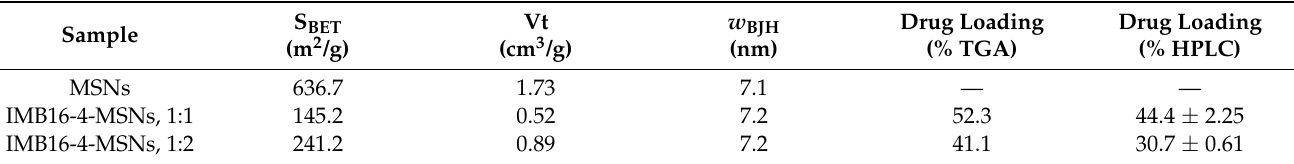
Figure 3. TGA of MSNs and IMB16-4-MSNs samples ( A ). UV-Vis absorption spectra of raw IMB16-4, MSNs, IMB16-4-MSNs and chemical structural of IMB16-4 ( B ). Table 1. Properties characterization for MSNs and IMB16-4-MSNs. Each data point represents the mean ± SD of three